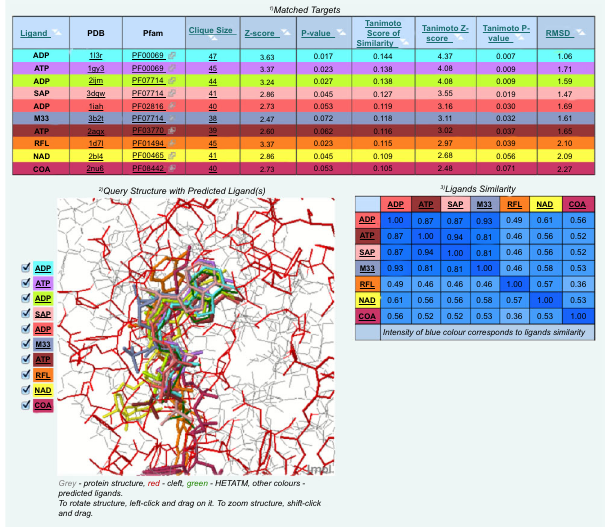
Figure 6. Example of the IsoCleft Finder output containing the list of hits (top) superimposed on the query binding-site of 3e7e (bottom left) and the target ligand similarities (bottom